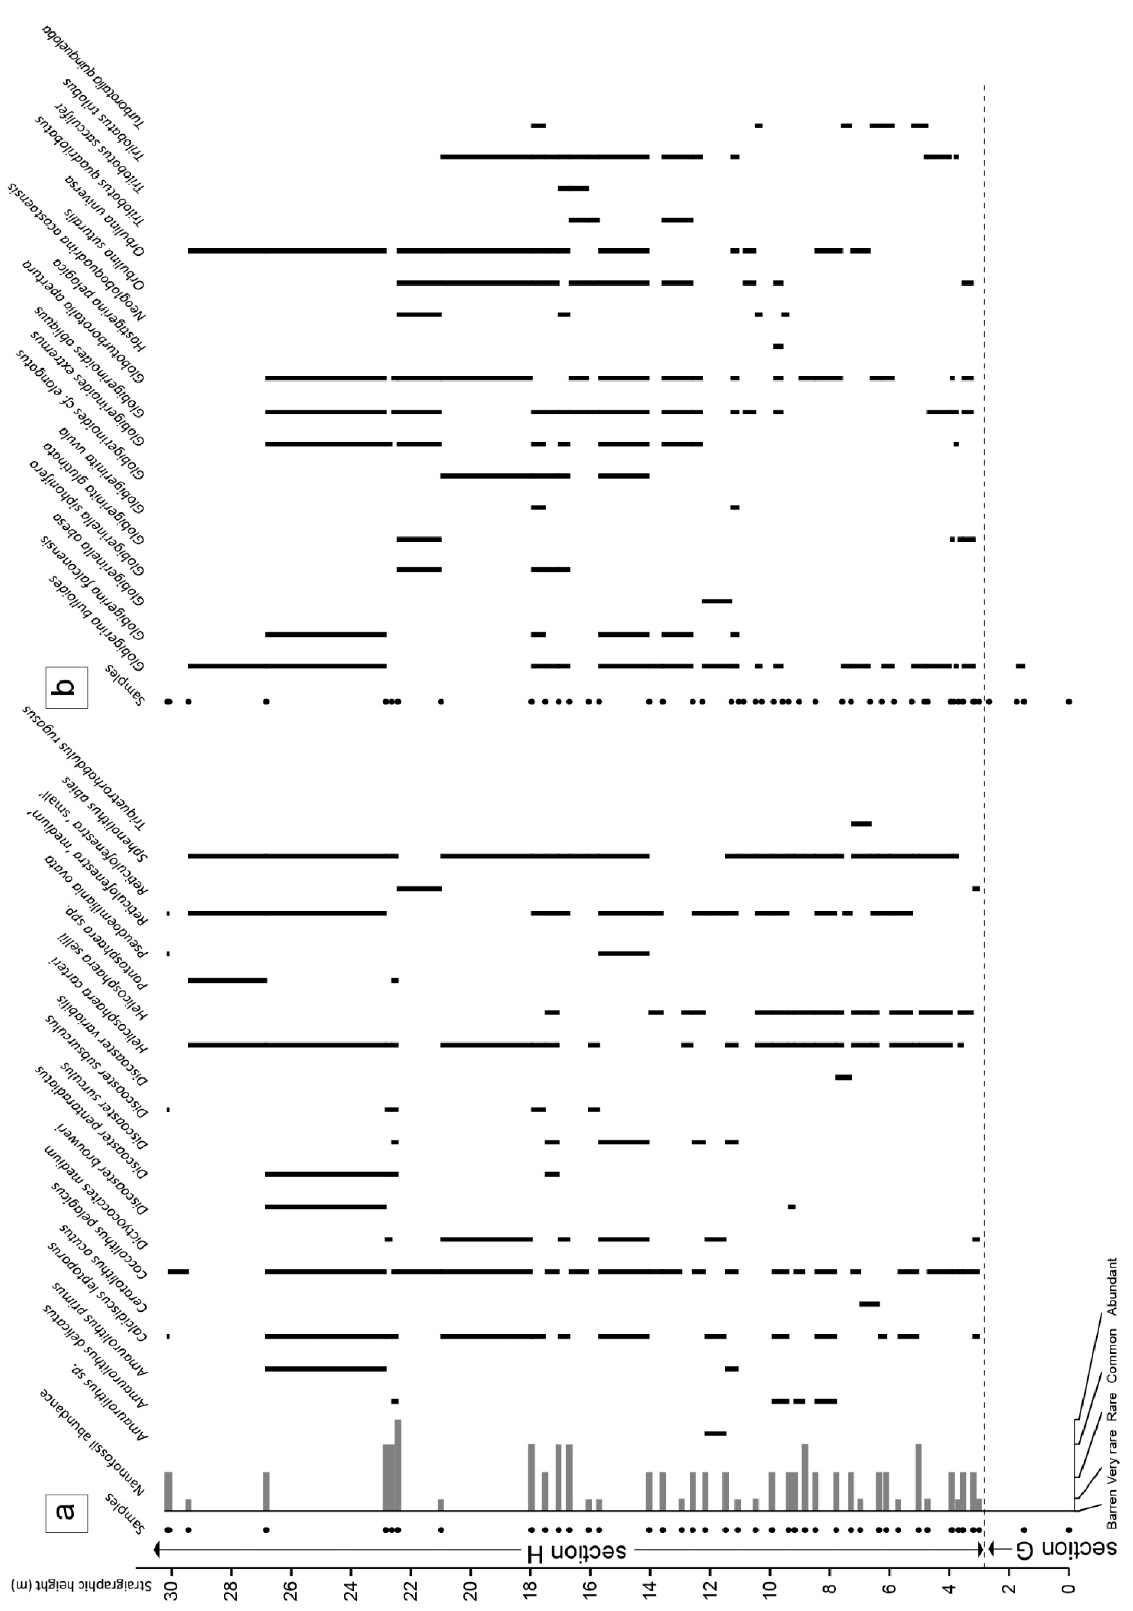
Figure 10. Stratigraphic distribution of ( a ) calcareous nannofossils and ( b ) planktonic Foraminifera in the Brunella composite section based on samples from sections G and H.